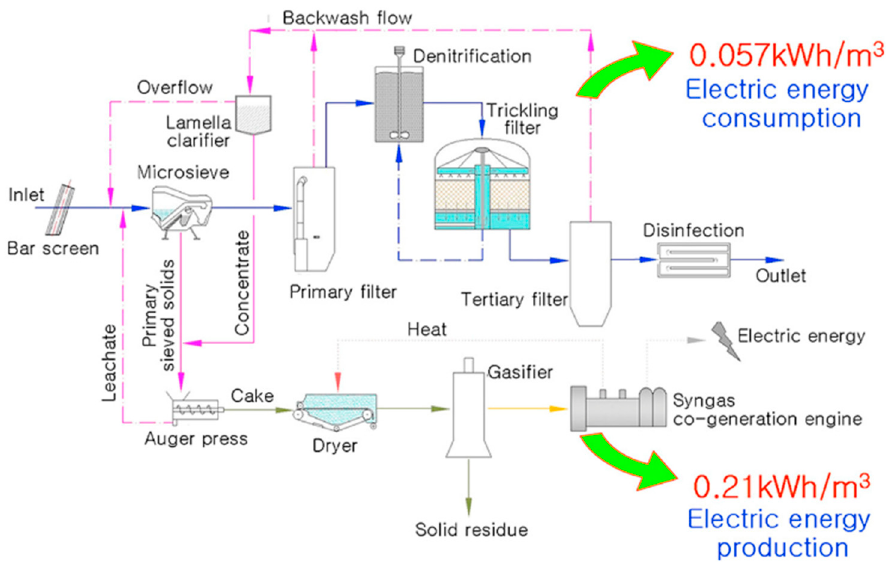
Figure 5. Diagram of a theoretical energy positive WWTP [14].